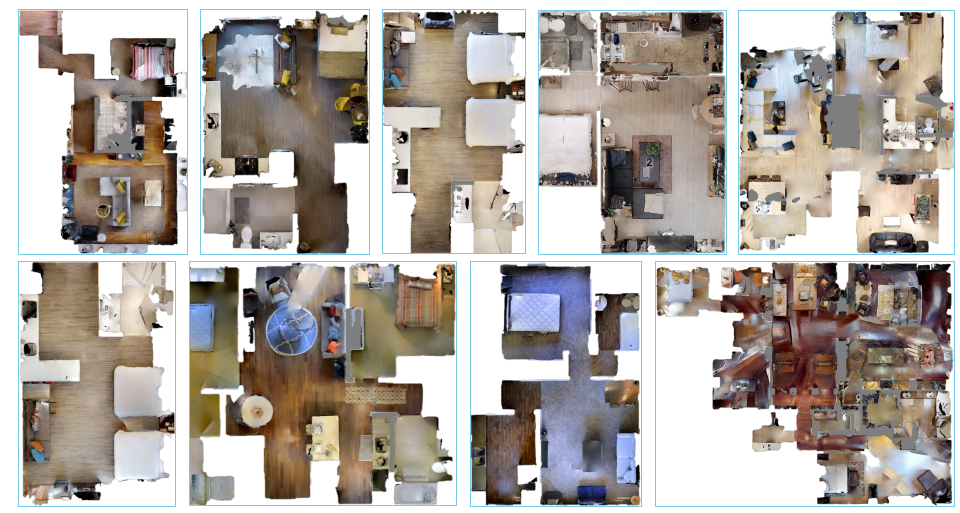
Figure 15. Top view of nine simulation experiment scenarios in the Gibson dataset.